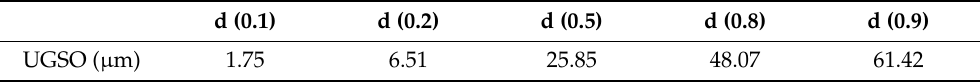
Table 4. Particle size distribution of UGSO-L1.